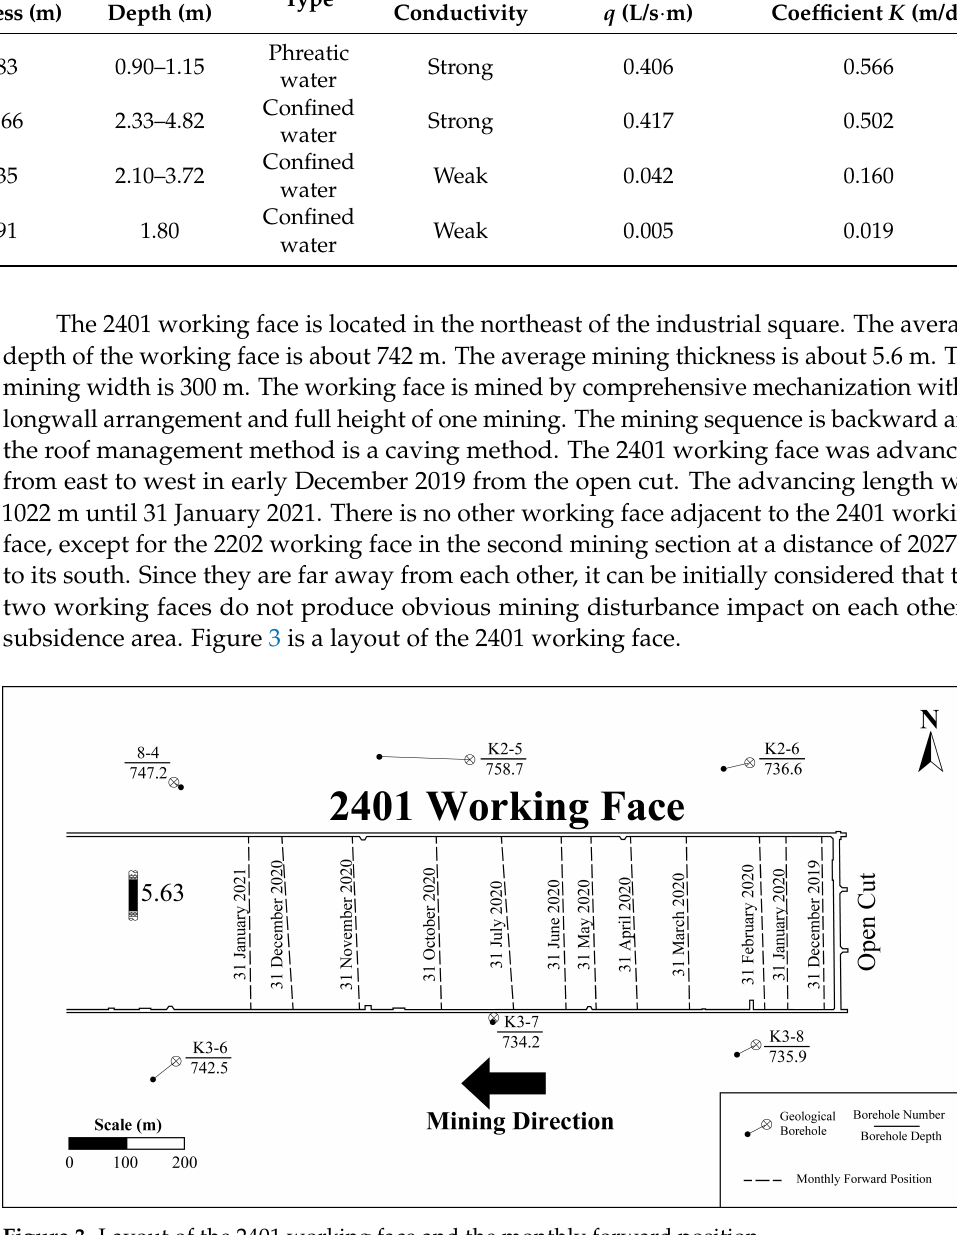
Figure 3. Layout of the 2401 working face and the monthly forward